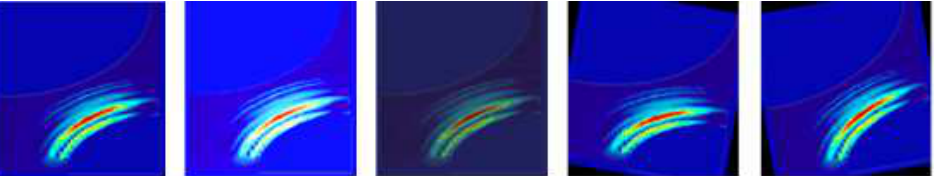
Figure 10. Data augmentations with original image, increasing of the brightness and darkness, rotating left 10 degrees, and rotating right 10 degrees.